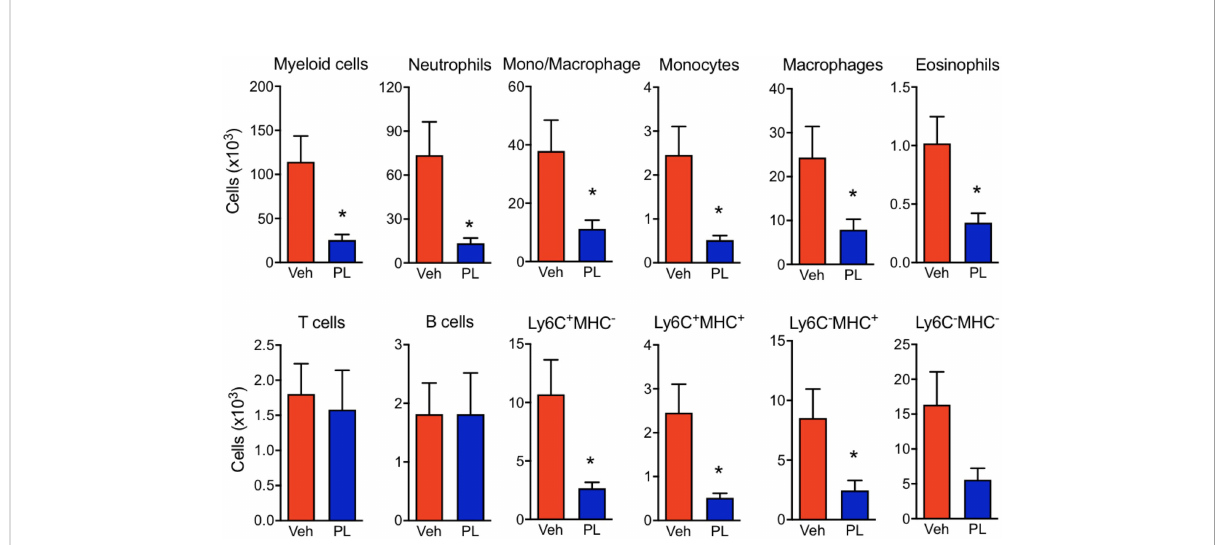
FIGURE 6 Effect of PL8177 in immune cell recruitment to arthritic joints. Flow cytometry analysis of hind paw cells of arthritic vehicle-treated (Veh) and PL8177-treated (3 mg/kg) mice was performed. Total cell numbers were obtained by normalization with quanti fi cation beads added upon enzymatic digestion. The gating strategy is provided in Supplementary Figure 1.The different populations were de fi ned as follows: total myeloid cells (CD45 + CD11b + ), neutrophils (CD45 + CD11b + Ly6G + ), mono-macrophages (CD45 + CD11b + SiglecF - Ly6G - ), monocytes (CD45 + CD11b + SiglecF - Ly6G hi F4/80 lo ), macrophages (CD45 + CD11b + SiglecF - Ly6G lo F4/80 hi ), eosinophils (CD45 + CD11b + SiglecF + ), T cells (CD45 + CD11b - B220 - CD3e + ), B cells (CD45 + CD11b - B220 + ). The mono/Macrophage population was also analysed based on Ly6C and MHC-II markers. Data are mean ± SEM of n=7 analyzed by t-test. * p <0.05 vs. vehicle-treated arthritic mice